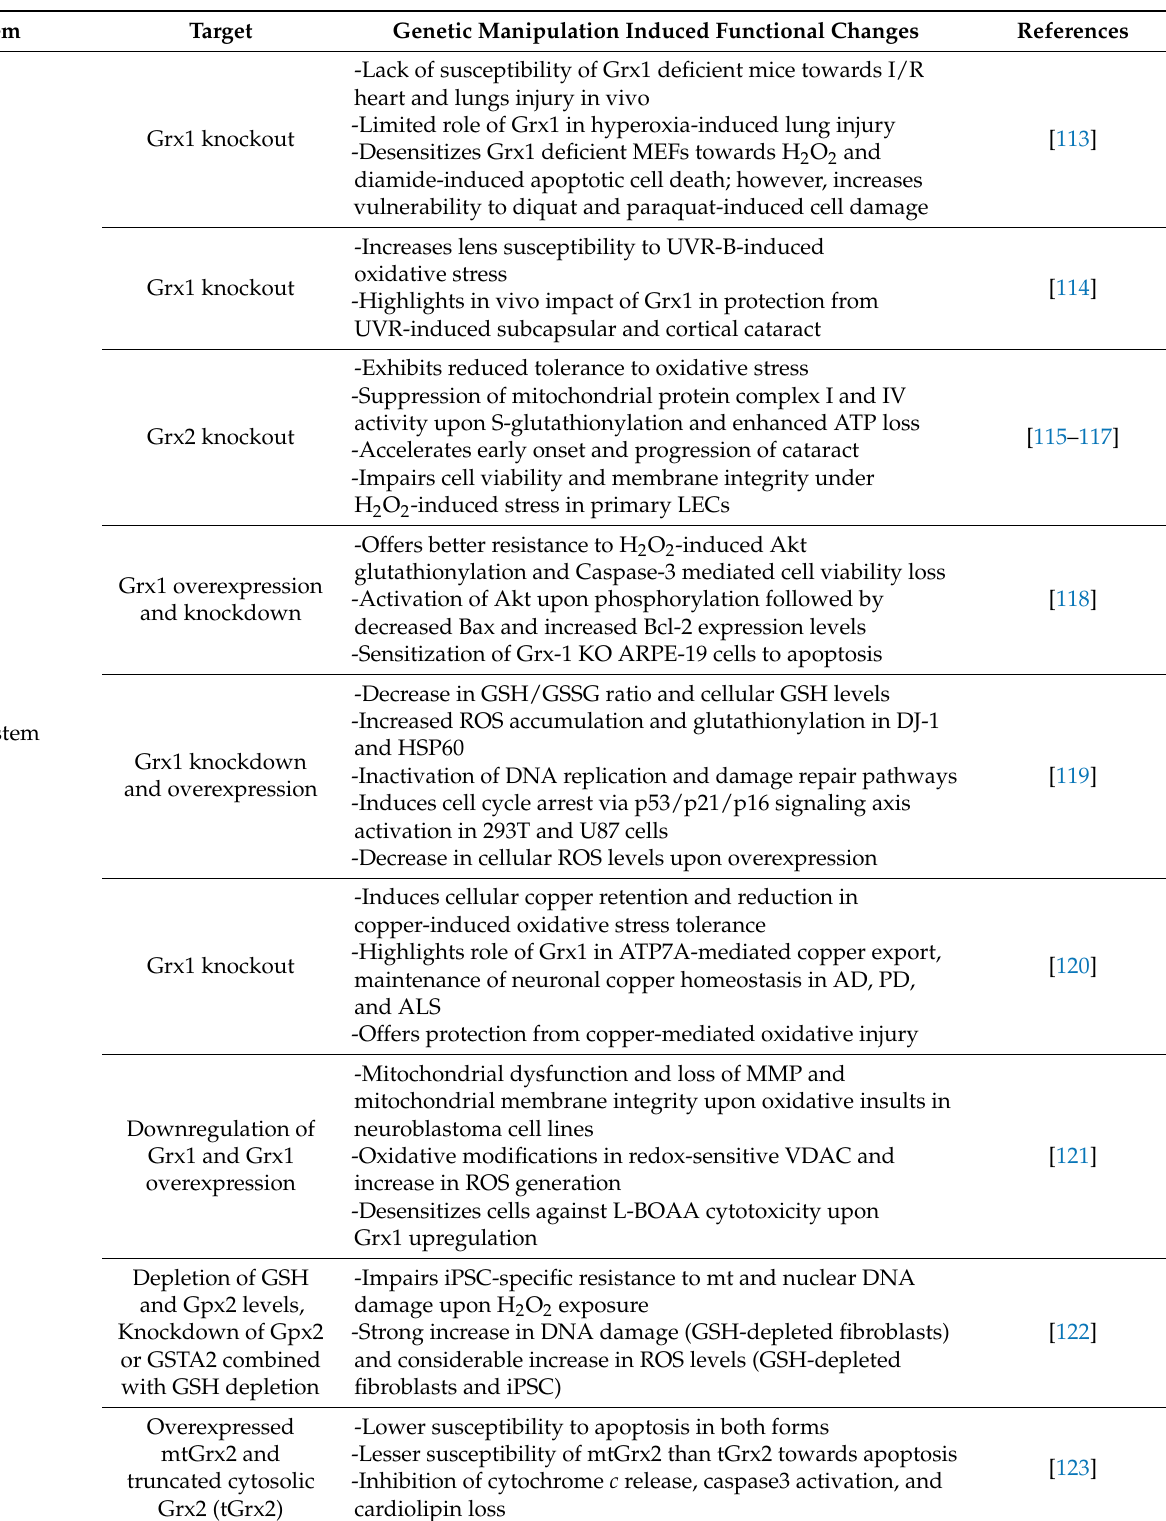
Table 1. Summarization of the specificity of Grx and Trx systems in altered redox environments supported byin vivo and in vitro experimental